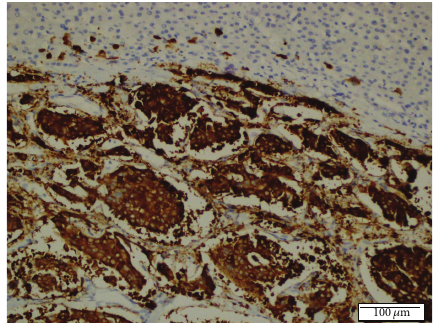
Figure 6: Diffuse, strong immunoreactivity for synaptophysin in tumor cells in the resected liver specimen. Immunohistochemical (IHC) staining, × 200.